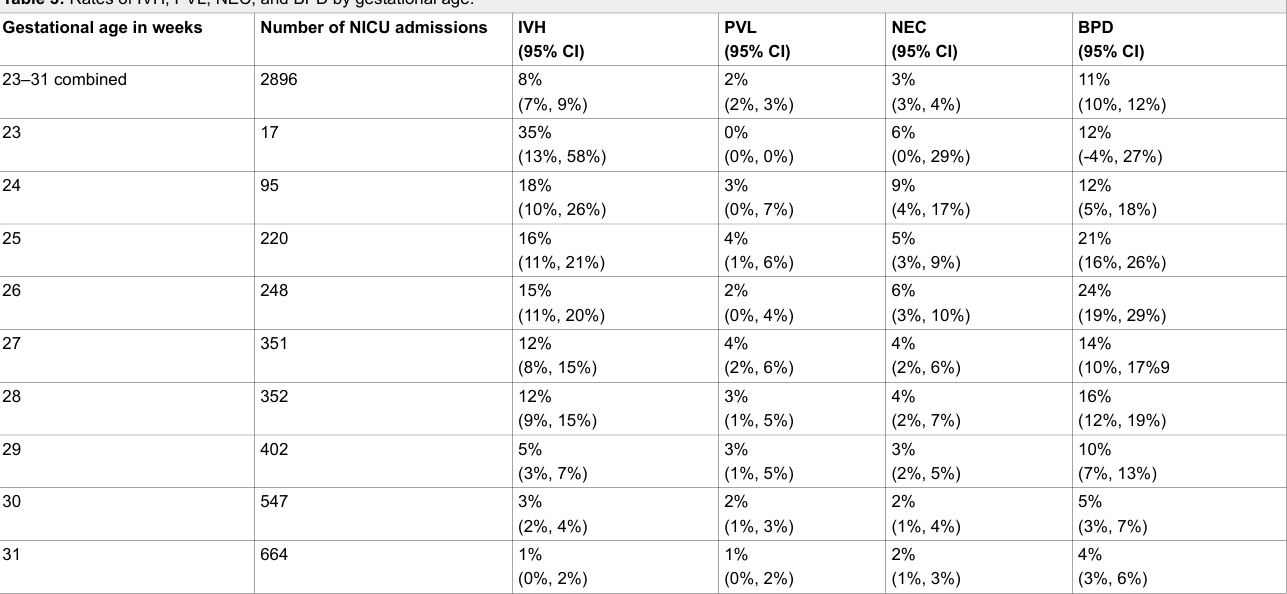
Table 3: Rates of IVH, PVL, NEC, and BPD by gestational age. Gestational age in